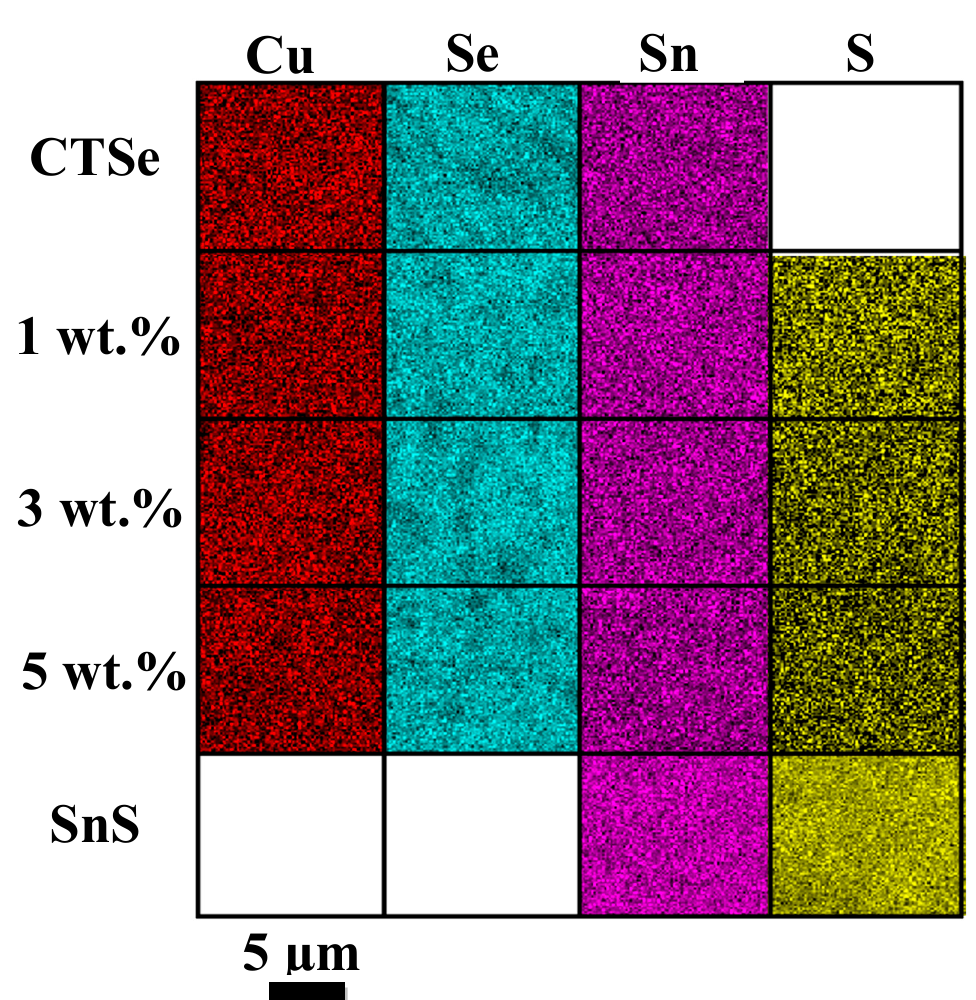
Figure 5. Energy dispersive spectroscopy (EDS) mapping images of the CTSe and SnS composites. The analyses were performed on the polished surfaces of the pellets.